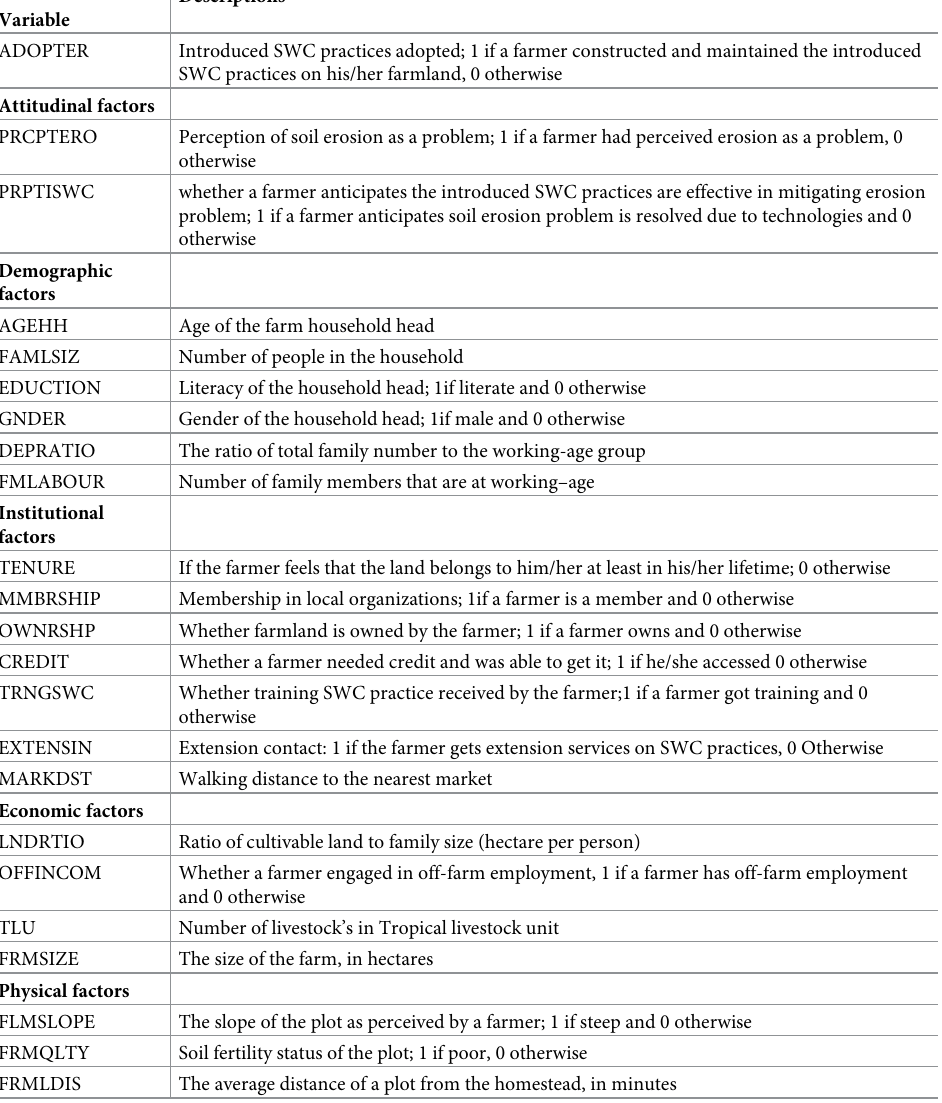
Table 1. Definition of explanatory variables used in the